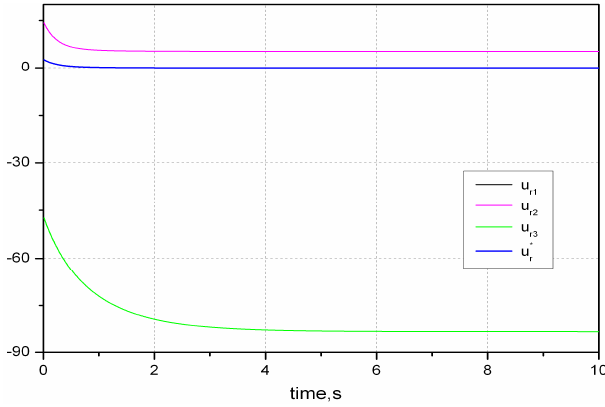
Figure 3. Control rates with OAMTC limit regulator.